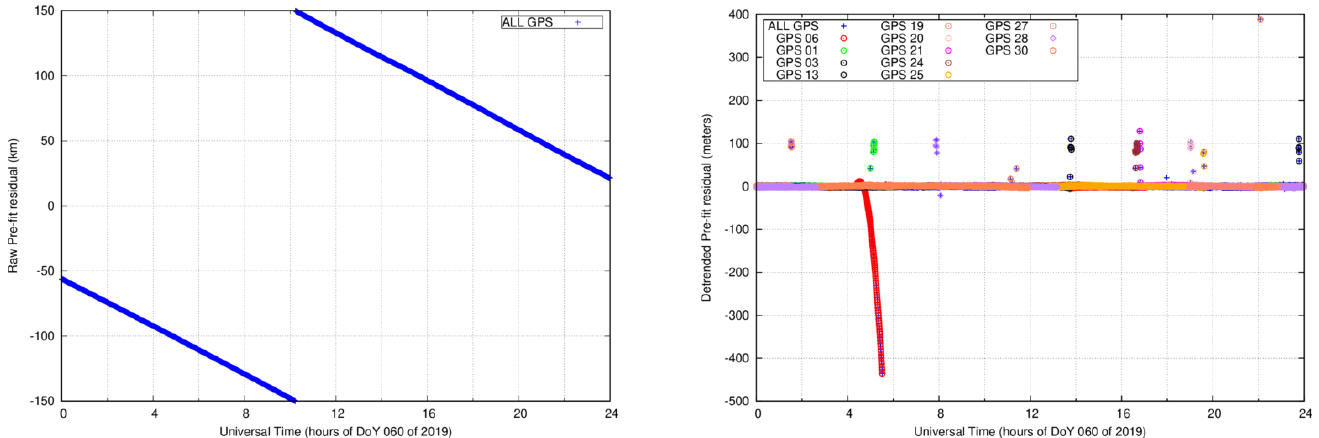
Figure 3. Actual pre-fit residuals recorded by station HUEG during 1 March 2019. The left plot depicts the raw pre-fit residuals, whereas the right plot depicts the pre-fit residuals linearly detrended. All satellites are depicted in blue color, while pre-fit residuals with outliers are depicted with